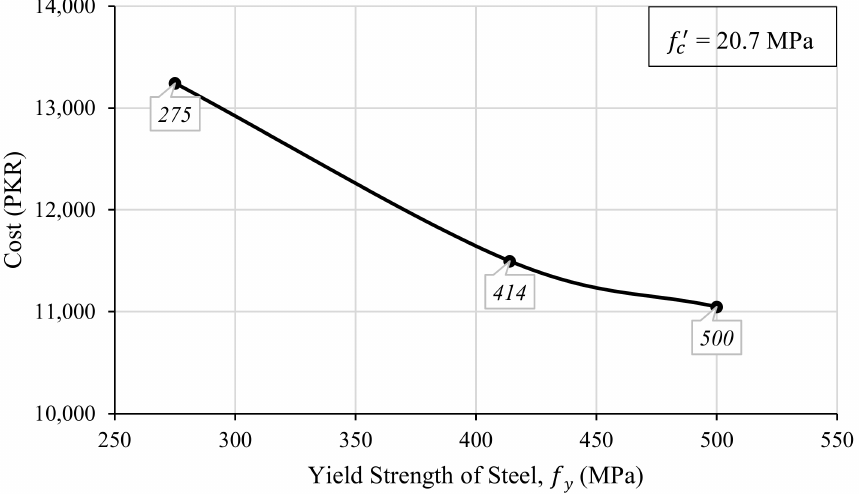
Figure 9. The relationship between the yield strength of the steel and the construction cost of the beam.